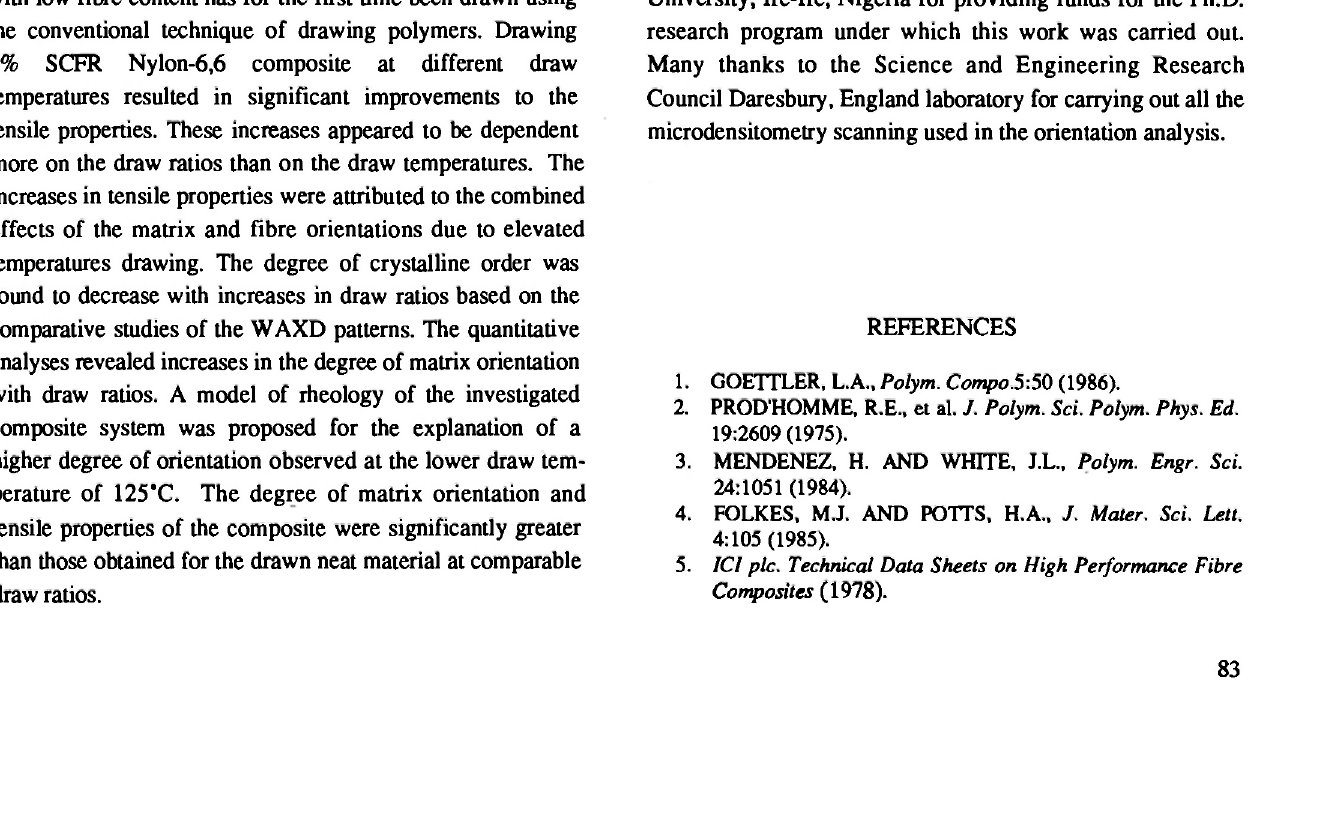
draw ratio Fig. 10: Half width at half maximum intensity against draw ratios at different draw temperatures for drawn 5% SCFR Nylon-6,6 composite at different temperatures (curve 2) and drawn neat Nylon-6,6 fibres at comparable high temperature (curve 1)